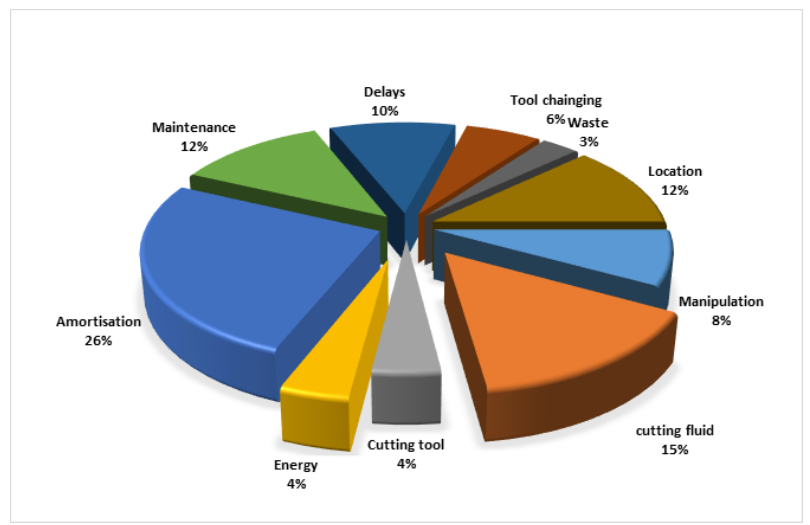
Figure 1. Machining cost breakdown